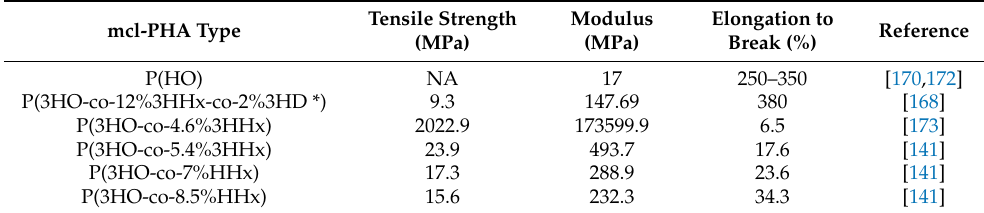
Table 4. Mechanical properties of various types of